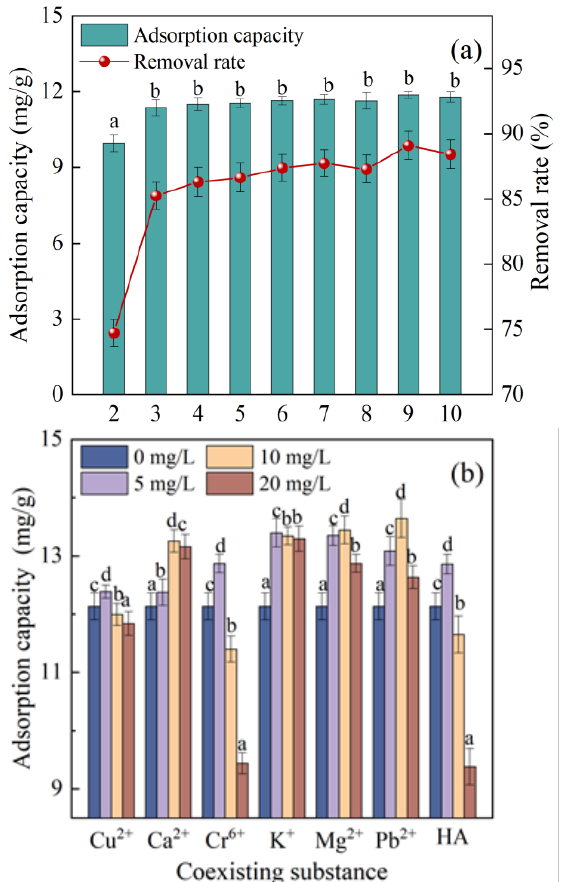
Figure 5. Effects of initial solution pH and coexisting substances on the adsorption of diuron by SDMBC600: ( a ) initial solution pH; ( b ) coexisting substances. (10 mg/L diuron, 0.075 g SDMBC600, t = 360 min). Different letters indicate significant differences between different treatments at the 0.05 level, testing by one-way ANOVA.